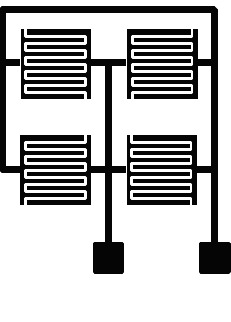
Figure 2. Lateral sensor